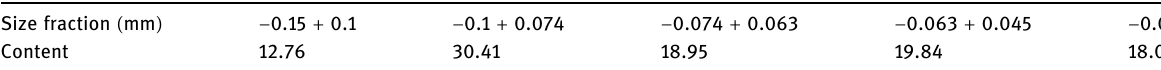
Table 2: Size distribution of the reduced iron ( mass % )